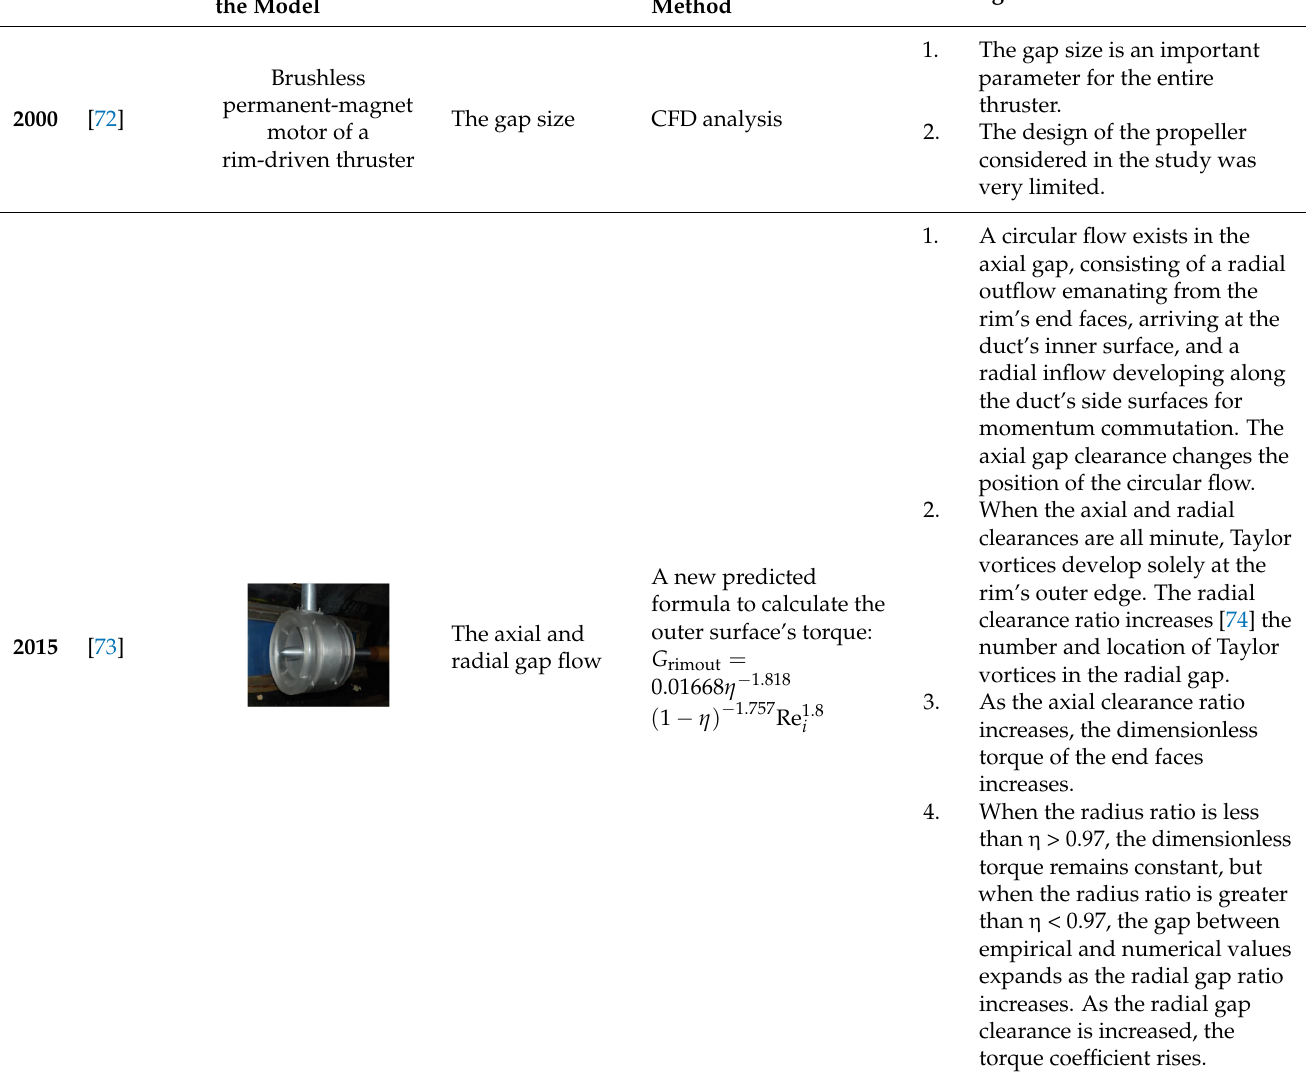
Table 5. Summary of the effect of the gap-flow model on the hydrodynamic performance of IMP thrusters.